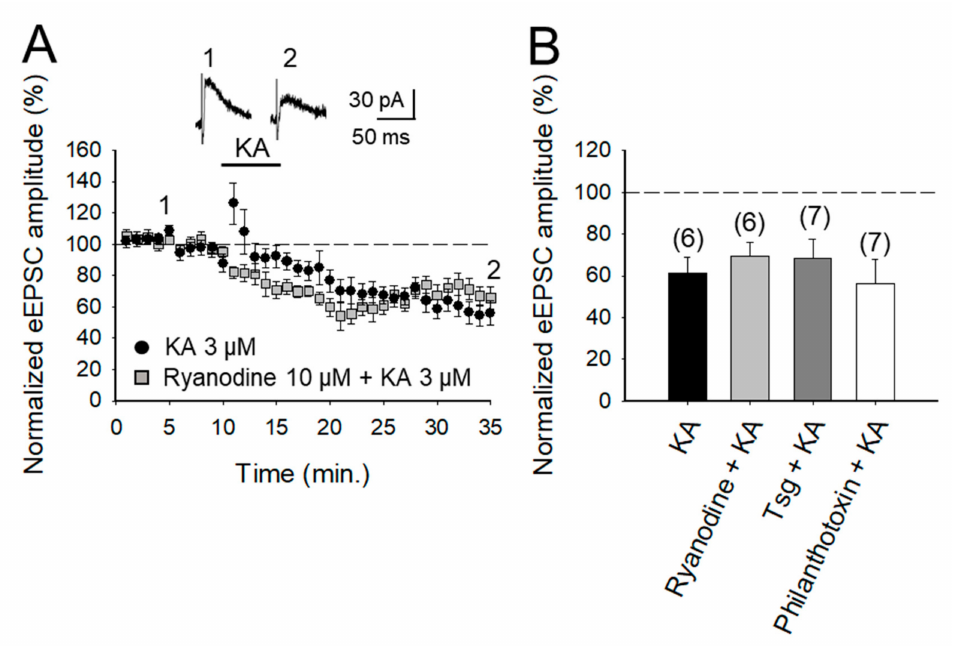
Figure 4. KAR-mediated depression of glutamate release does not require changes in Ca 2 + in the cytosol at the PF-PuC synapses. ( A ) Time-course of KA (3 µ M) e ff ect on eEPSC amplitude under the control condition (circles) and in slices treated with Ryanodine (squares). ( B ) Quantification of results for slices treated with ryanodine, thapsigargin and Philanthotoxin. The decrease of eEPSC amplitudes induced by KA is not prevented in any case. The number of slices (from two to three mice) is indicated in parentheses at the top of each bar. Results are expressed as means ± SEM (Student’s t -test and